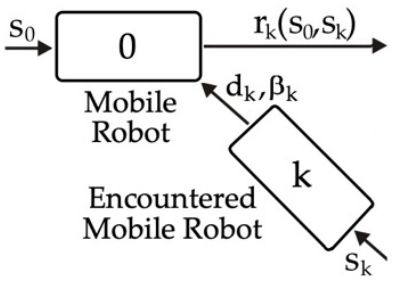
Figure 3. Block representation of a matrix game model of a group of mobile robots: s 0 ( ψ 0 , v 0 )— mobile robot strategies, s k ( ψ k , v k )— k th encountered mobile robot strategies, and r k ( s 0 , s k )—collision risk of the mobile robot with the k th encountered mobile robot.